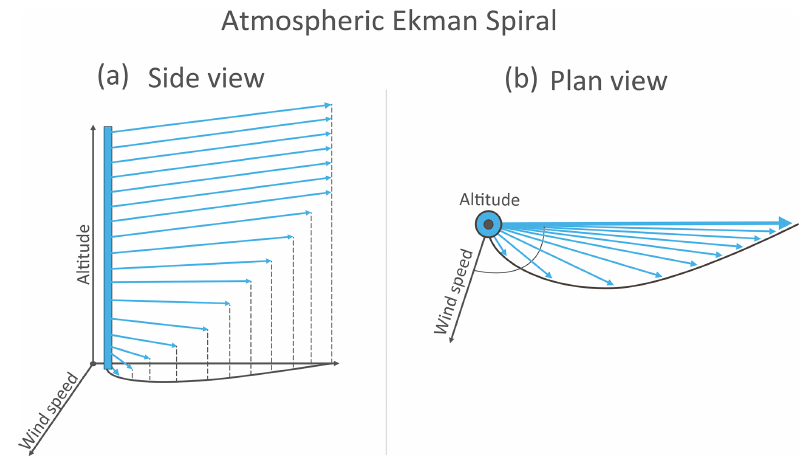
Figure 4. Schematic describing the process behind an Ekman spiral from the (a) side and (b) plan views. This diagram shows the spiral for the Southern